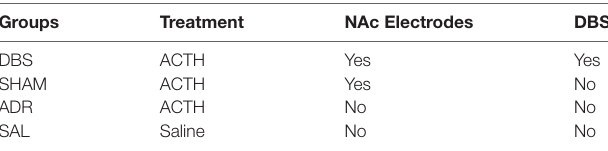
TABLE 1 | Group treatments. Groups